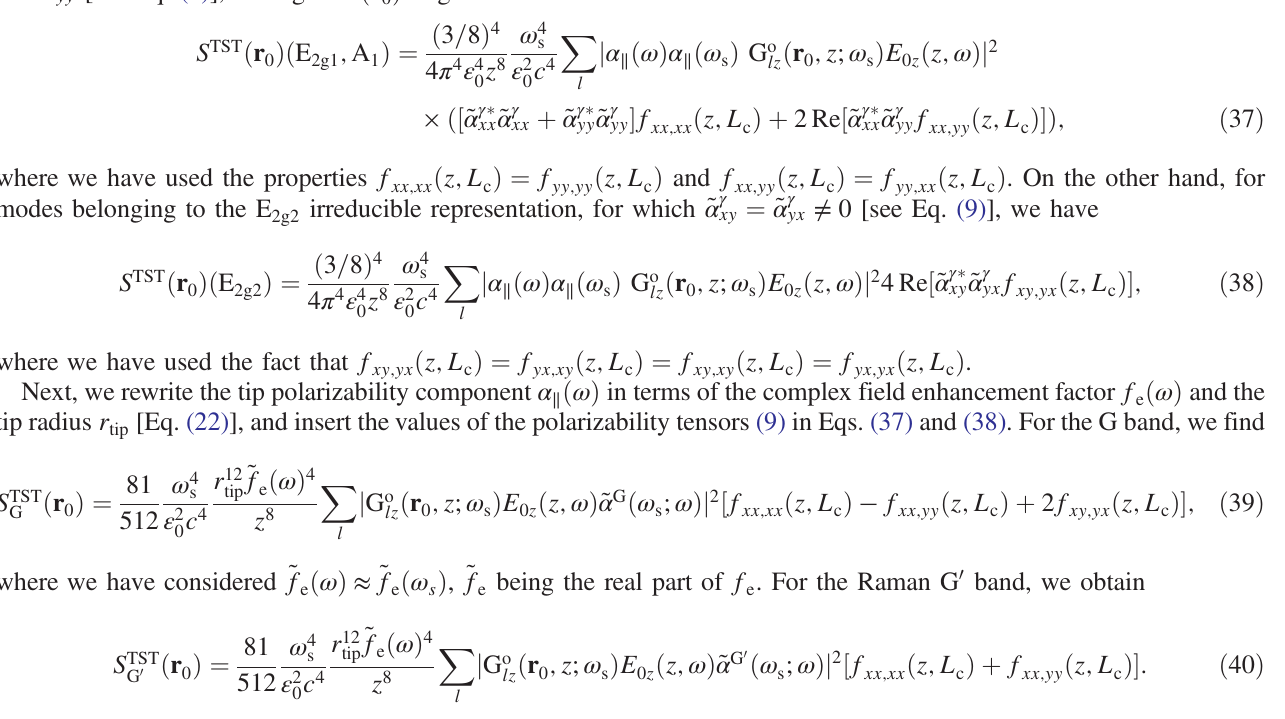
Fig. 5 indicate that the phonon correlation length in graphene can be experimentally determined by measuring the G and G 0 approach